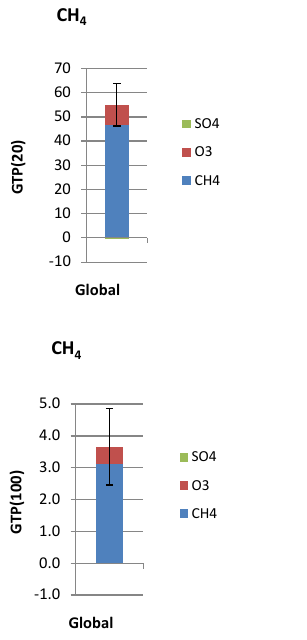
Fig. 2. GTP(20) and GTP(100) for global emissions of CH 4 . The GTPs are split according to the contributing components. The con- tribution from stratospheric water vapour is included in with CH 4 . Error bars reflect 1 standard deviation uncertainty in the multi- model